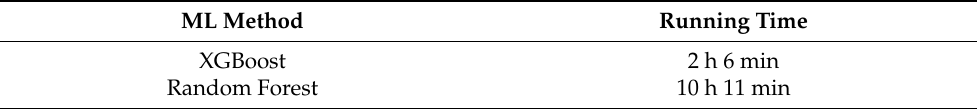
Table 4. Computation time for predicting all body features using the proposed